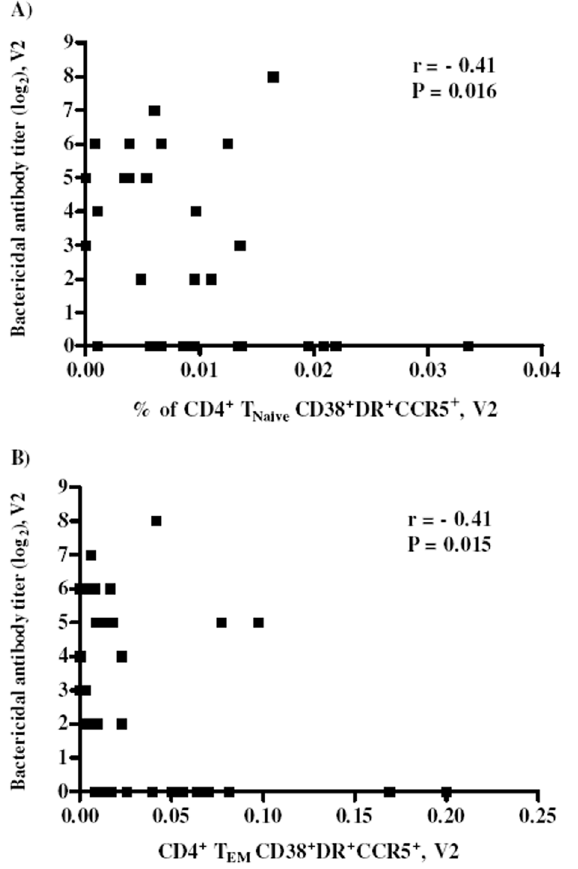
Fig. 5. Triple positive CD4 + T cells negatively correlates with bactericidal antibody titers. CD4 + T NAIVE (A) and T EM (B) T cells with CD38 + DR + CCR5 + phenotype correlates negatively with post-vacciantion bactericidal titers (V2). Correlations were analyzed using Sperman rank test.